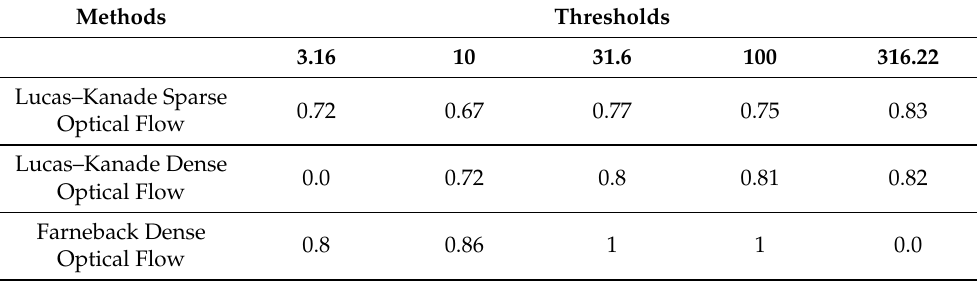
Table 5. Precision of each method grouped by